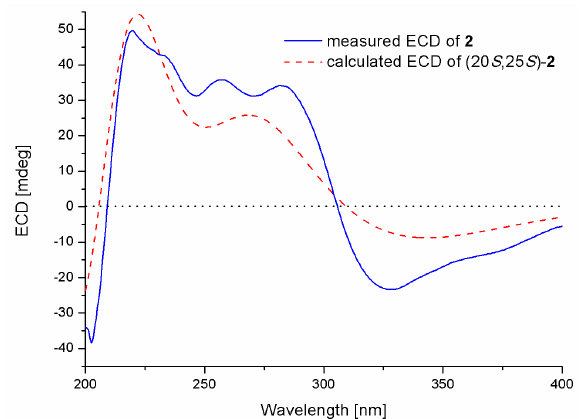
Figure 3. Experimental and calculated (electronic circular dichroism) ECD spectra of compound 1 in MeOH (Blue solid line and red dotted line represent measured and calculated ECD spectra, respectively; X- and Y-axis represent wavelength and ECD value.).